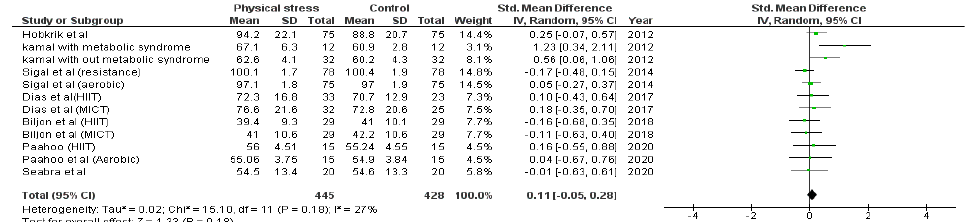
Figure 2. Forest plot showing the results for body weight.